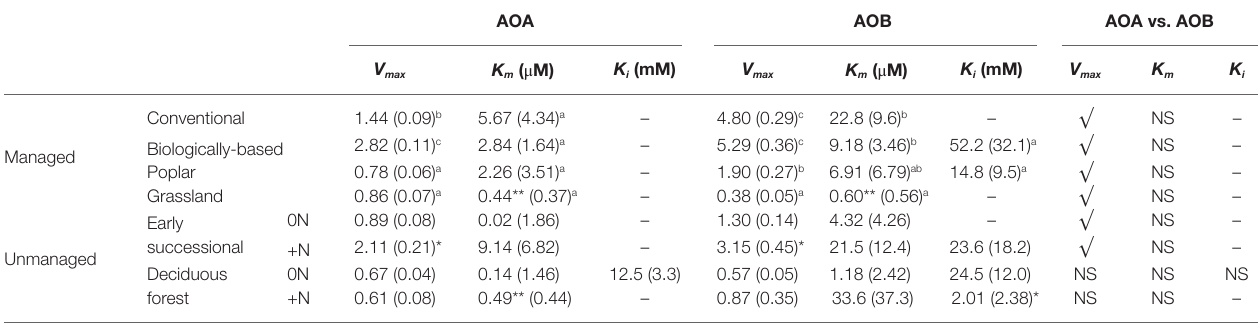
TABLE 2 | Kinetics parameters of managed systems and unmanaged systems for AOA and AOB nitrification; “+N” indicates subplots receiving long-term N fertilizer. AOA